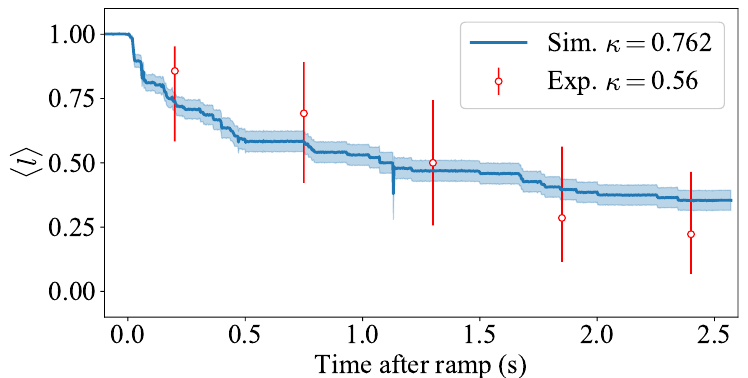
Figure 6: Average winding number as a function of time after the barrier reaches its maximum height ( t − t ) for T = 85nK. The normalised barrier height 2 κ ≡ V /µ = 0.762 for the simulation result (blue) is chosen to give close agree- b ment with the experimental data for κ = 0.56 (red open circles). The discrepancy in the barrier heights is quantified in Section 4.2 and discussed further in Sec. 5. Shaded region and errors bars give a 95% confidence interval in the simulation and experimental data,